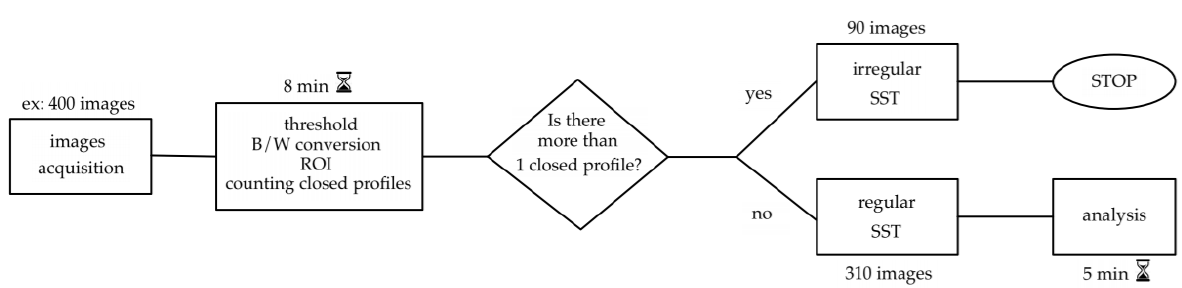
Figure 3. Flowchart outlining the method steps from image acquisition to final analysis with an example of processing time.